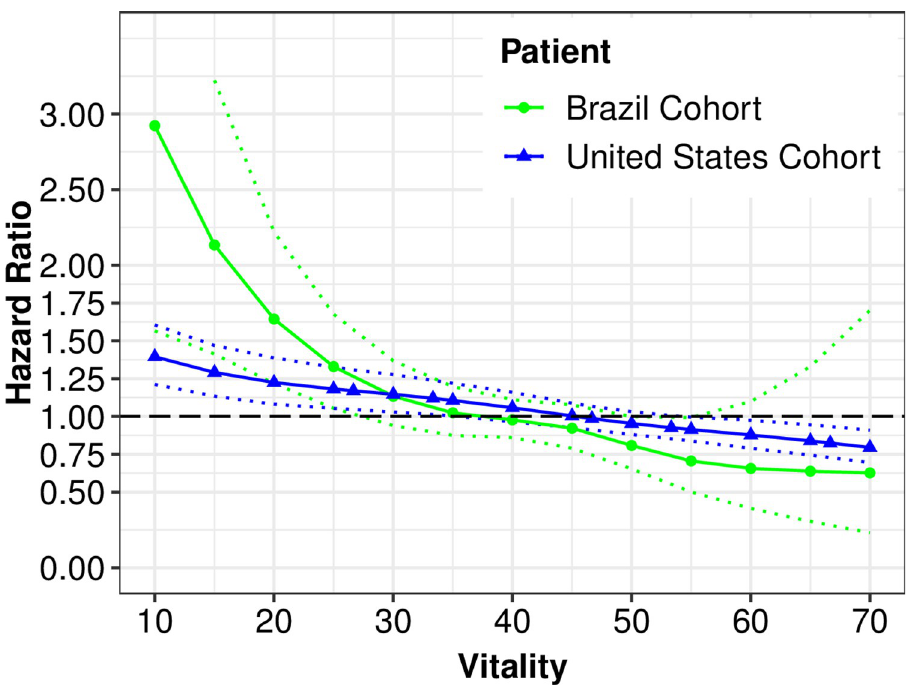
Fig 3. Smoothing splines for the hazard ratio of mortality by continuous vitality scores in the cohorts from Brazil (Green) and the United States (Blue). Models are adjusted for history of diabetes, coronary artery disease, peripheral artery disease, previous history of HD treatment, initial PD modality, hemoglobin, creatinine and age.